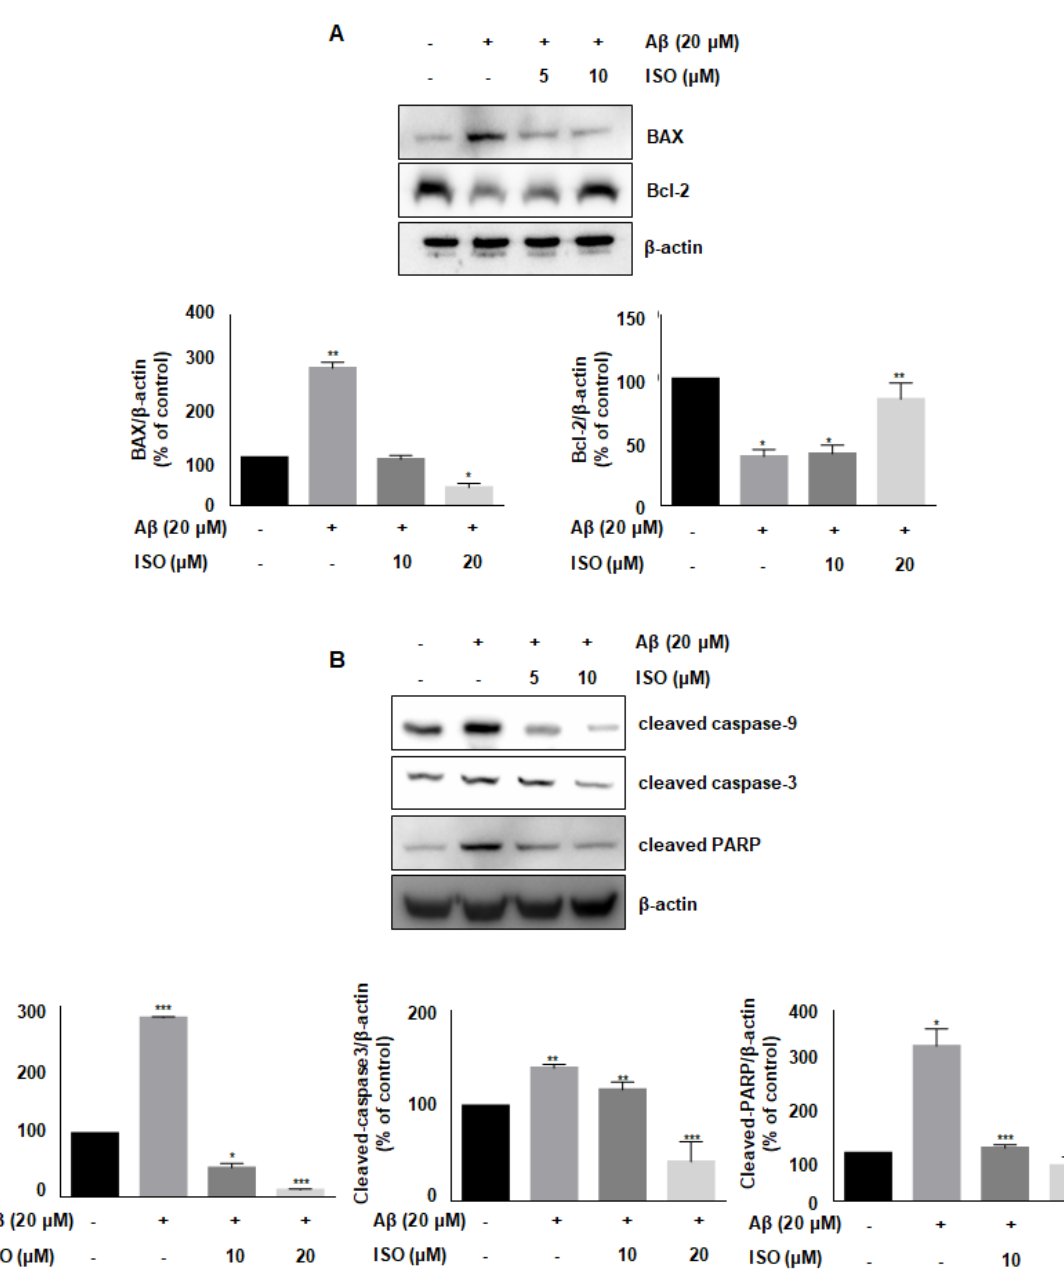
Figure 4. ISO blocks A β 25–35 -induced apoptosis in BV2 microglial cells. BV2 cells were pretreated with different concentrations of ISO as indicated 1 h before the addition of A β 25–35. ( A ) The protein levels of Bax and Bcl-2 were observed by Western blot analysis. ( B ) The levels of cleaved caspase-9, -3, and PARP were observed by Western blot analysis. β -actin was used as loading controls. The experiments were repeated more than three times and similar results were obtained. Data indicate mean ± SEM of three independent experiments. * p < 0.05, ** p < 0.01, *** p < 0.001 versus control.